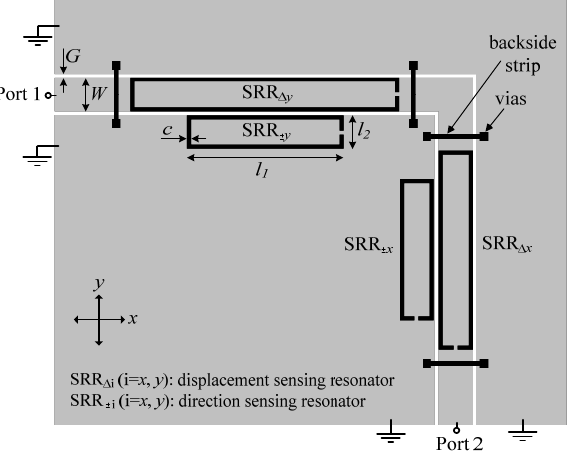
Figure 2. Layout of the proposed sensing device for the aligned position ( i.e ., the CPW and the displacement sensing SRRs are aligned). The CPW strip and slot widths are W = 1.67 mm and G = 0.2 mm, respectively, the vias have a 0.2 mm radius, and the narrow strips between vias have a width of 0.2 mm. The dimensions of the SRRs are: (SRR ) = 9.95 mm, l (SRR ) = 7.05 mm, l (SRR ) = 13.4 mm, l (SRR ) = 7.8 mm, l 1 Δ x 1 ± x 1 Δ y 1 ± y l = 1.67 mm, and c = 0.2 2